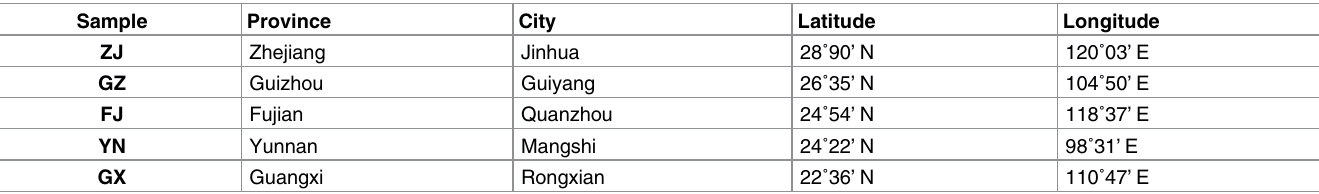
Table 1. Location of five geographically distributed planting bases of D . catenatum .